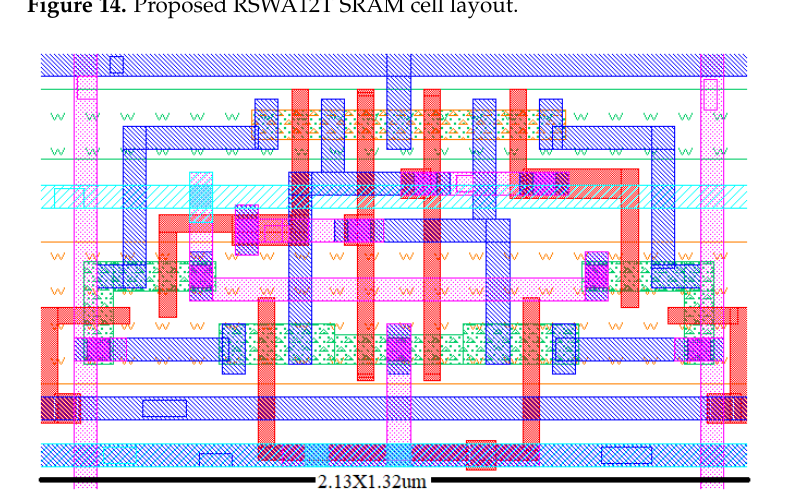
Figure 14. Proposed RSWA12T SRAM cell layout.